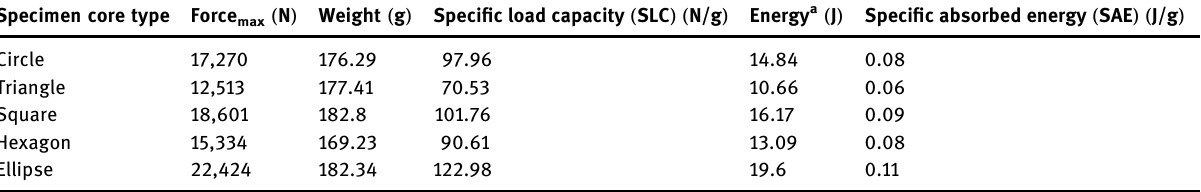
Table 2: Simulation results of the stainless - steel perforated sheet metal ( linear arrangement ) obtained from fi nite element